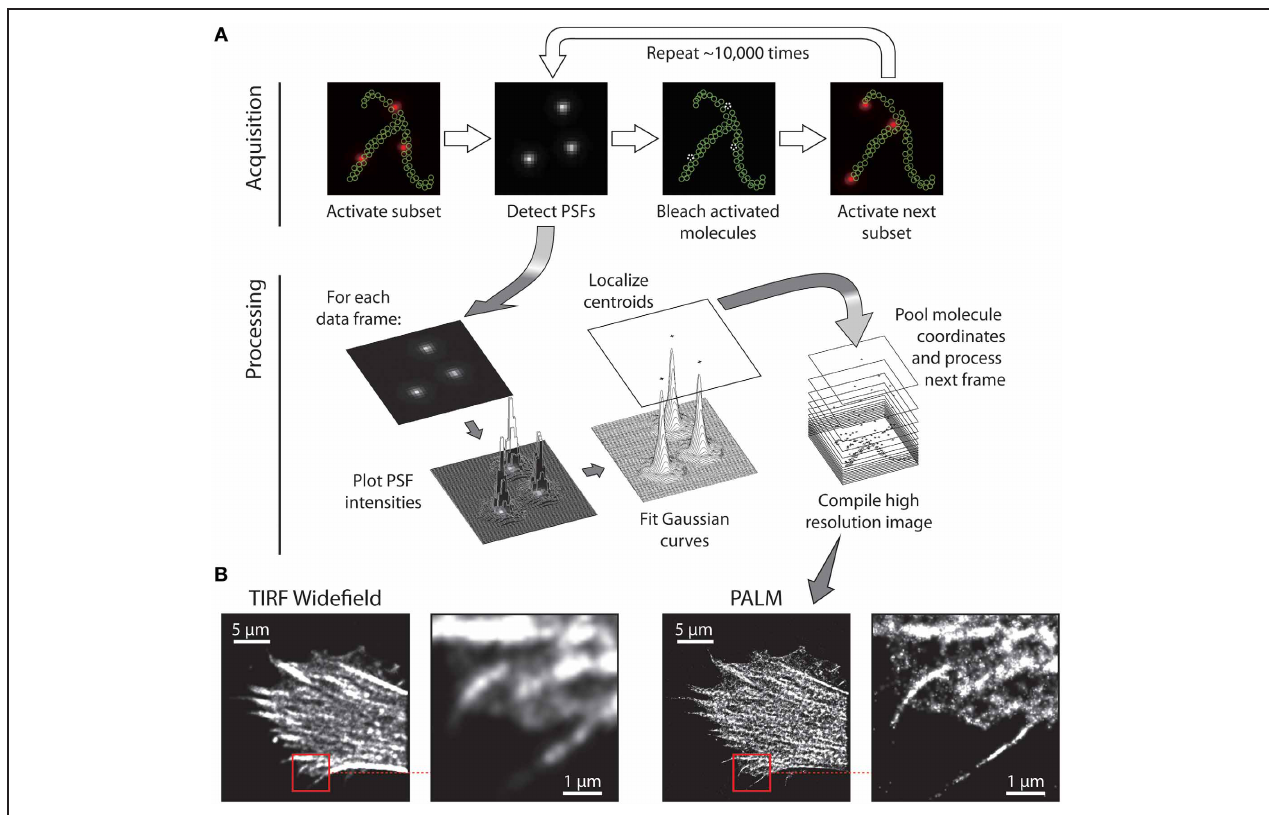
and fitting for typically 15,000–20,000 frames, a coordinate map of all detected molecules is generated. (B) Example data: HeLa cell expressing Lifeact (an F-actin binding protein) fused to the photoswitchable protein tdEos, observed with TIRF, widefield microscopy and then with TIRF PALM. The substantial increase in resolution is evident by comparing the zoomed TIRF and PALM regions, indicated by the red